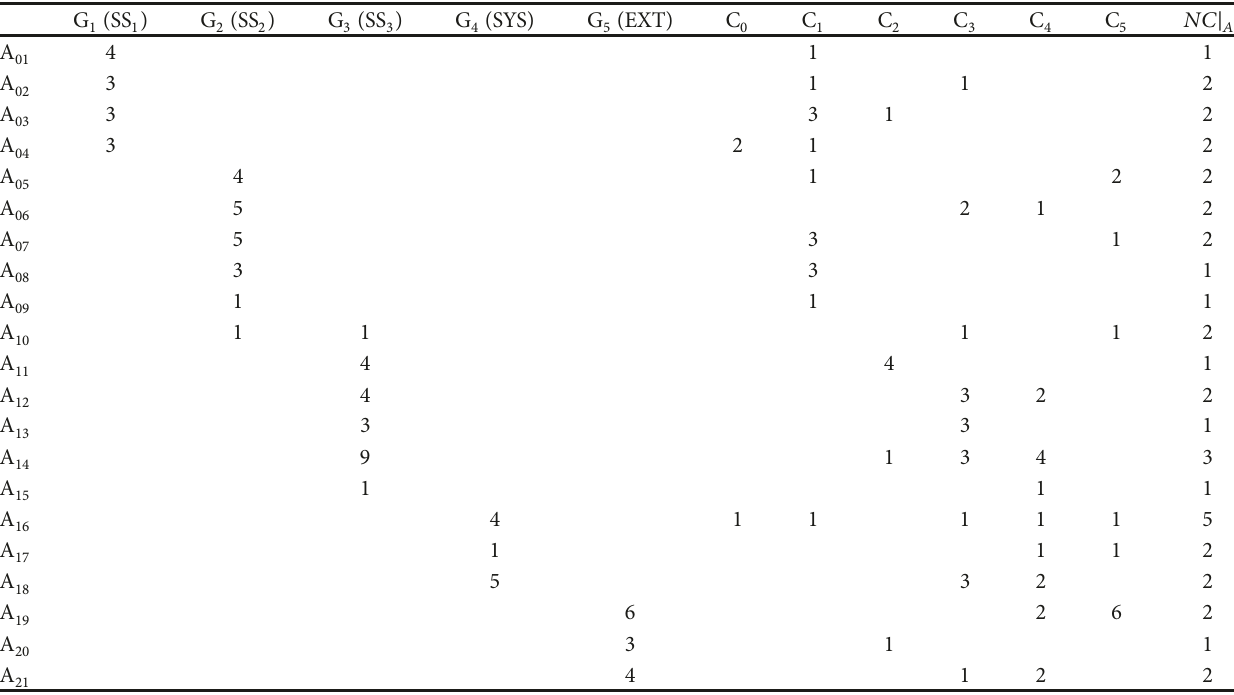
Table 3: Analysis of assignments of actors to